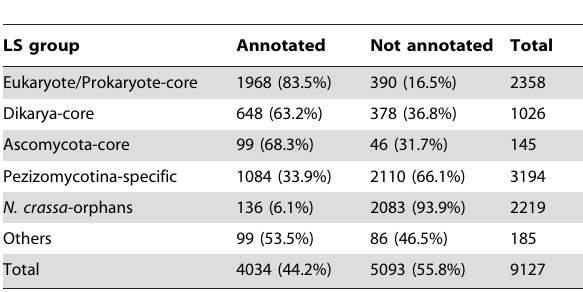
Table 1. Functional annotation status of N. crassa genes in LS